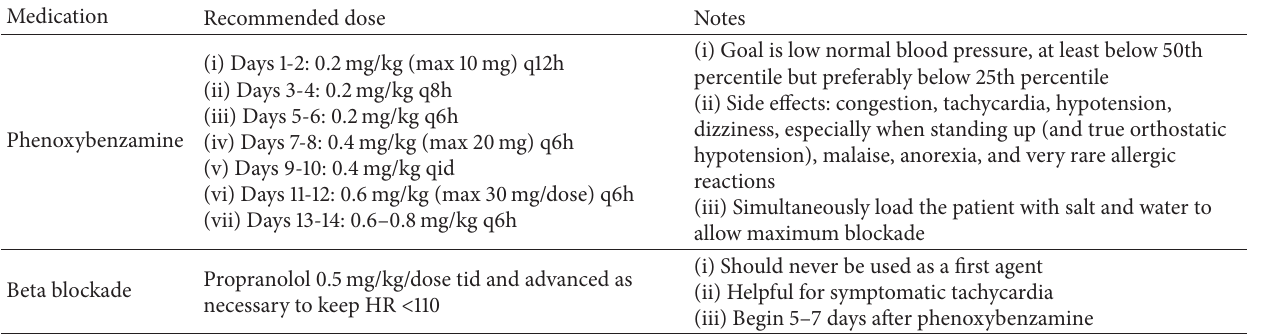
Figure 1: Radiologic imaging of the patient at presentation. (a, b, c) Computed tomography images showing a right-sided contrast-enhancing suprarenal mass (white arrows) displacing both the kidney and the liver. Note calcifications in the mass (arrow; image (c)), which is typical for pheochromocytoma. (d) MIBG nuclear scan showing uptake by the adrenal mass (arrow) and no evidence of other sites of disease. Table 2: Suggested algorithm for preoperative catecholamine blockade for PCC/PGL. Patients are best managed first with a pure alpha adrenergic blockade to relax arteriolar smooth muscles and reduce catecholamine-induced blood vessel constriction. Once the blood pressure is well-controlled, beta blockers can be added to treat